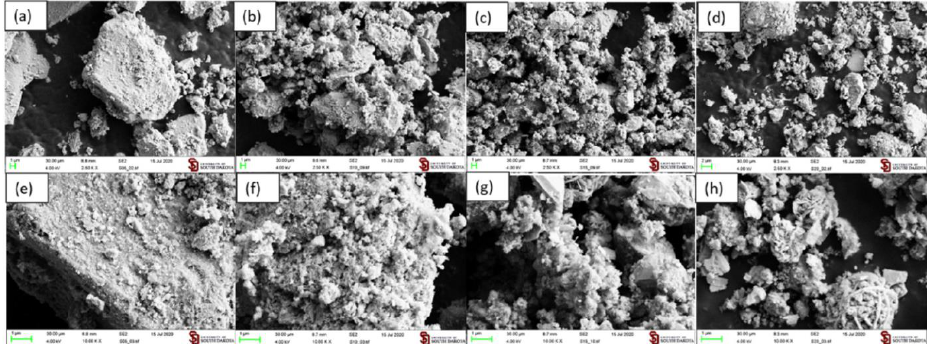
Figure 22. SEM images for different wt. % of SnS 2 /TiO 2 ( a , e ) 5%, ( b , f ) 10%, ( c , g ) 15%, and ( d , h ) 20%. nanocomposites. Reproduced with permission from